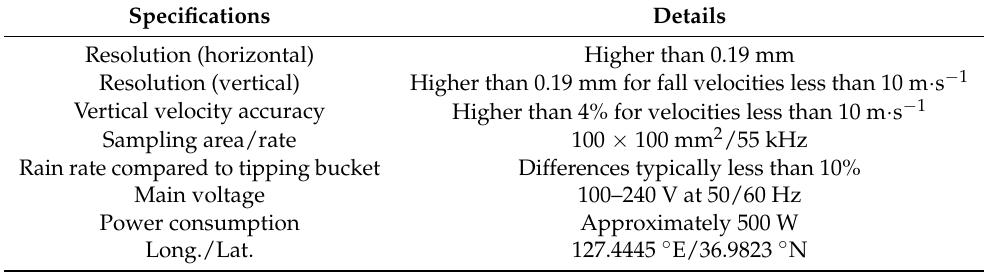
Table 3. Specifications of the 2DVD.